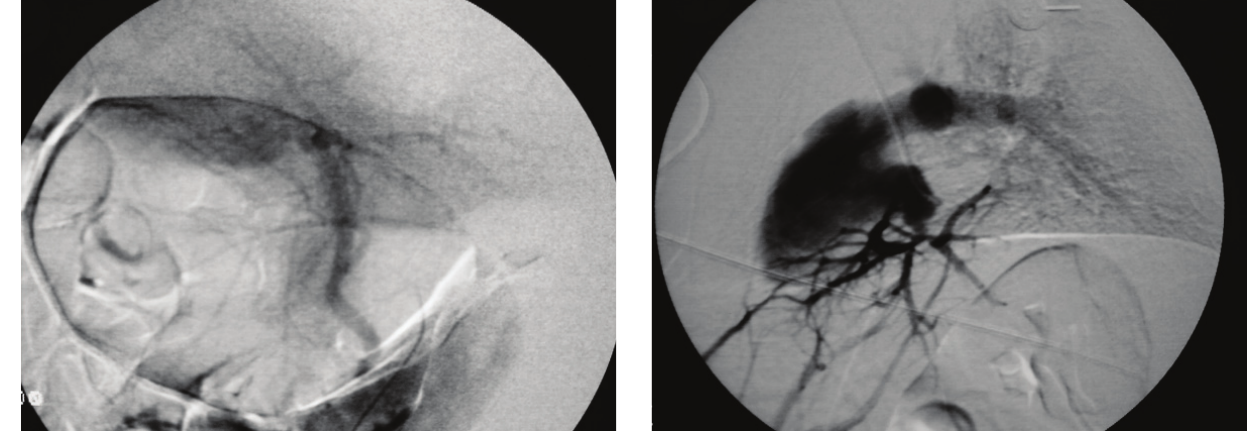
Figure 2 - Venous return phase of the superior mesenteric artery of the smaller twin, displaying the intra-and extra-hepatic portal vein